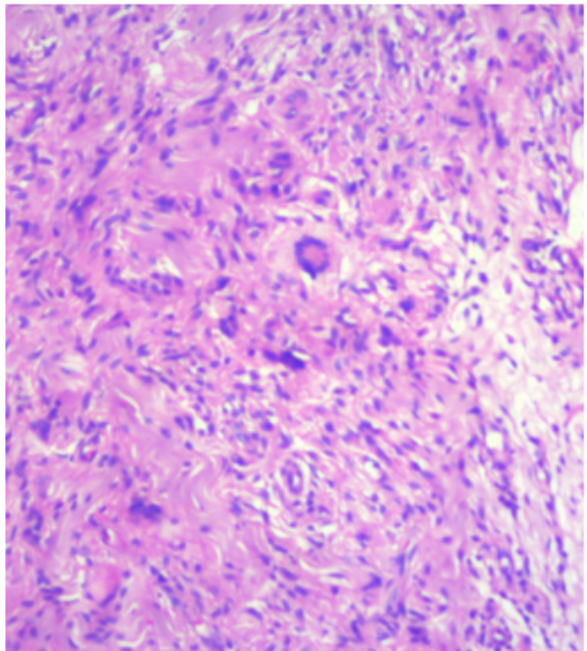
Figure 6: Histopathology showing mononucleated foamy histiocytes (xanthoma cells), aggregates of lymphocytes, plasma cells, and Touton giant